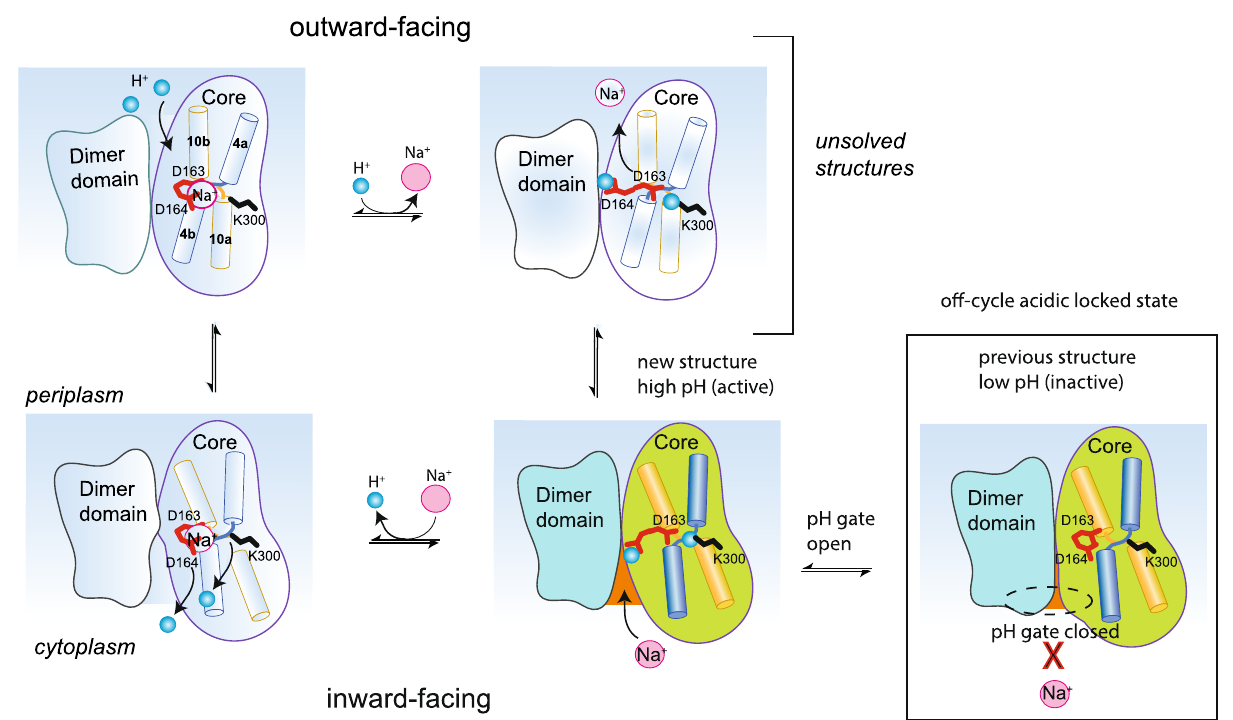
Fig. 5 | Schematic of the incorporation of the pH gating model with the alternating-access mechanism. The previous NhaA structures determined at low pH (PDB ID: 4AU5, 1ZCD) have been in acidic-locked conformation (<pH 4), which we interpret as an off-cycle intermediate unable to bind substrate Na + as the pH gate is closed (NhaA coloured in blue/green and outlined with box). The NhaA structure at active pH presented here (NhaA coloured in blue/green) has an open cavity caused by a rearrangement of charged residues involving histidine residues located in TM9. The active pH structure is part of the transport cycle and at active pH the binding of Na + from the cytoplasmic side to D163 and D163 triggers